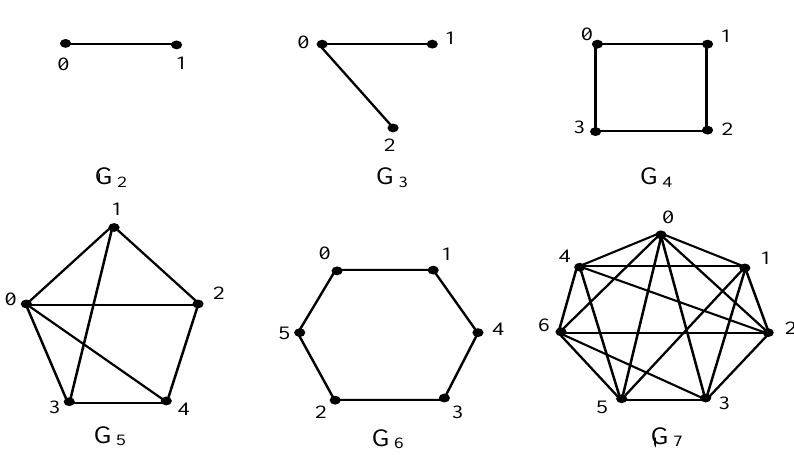
Figure 1. Examples of unitary addition Cayley graphs.